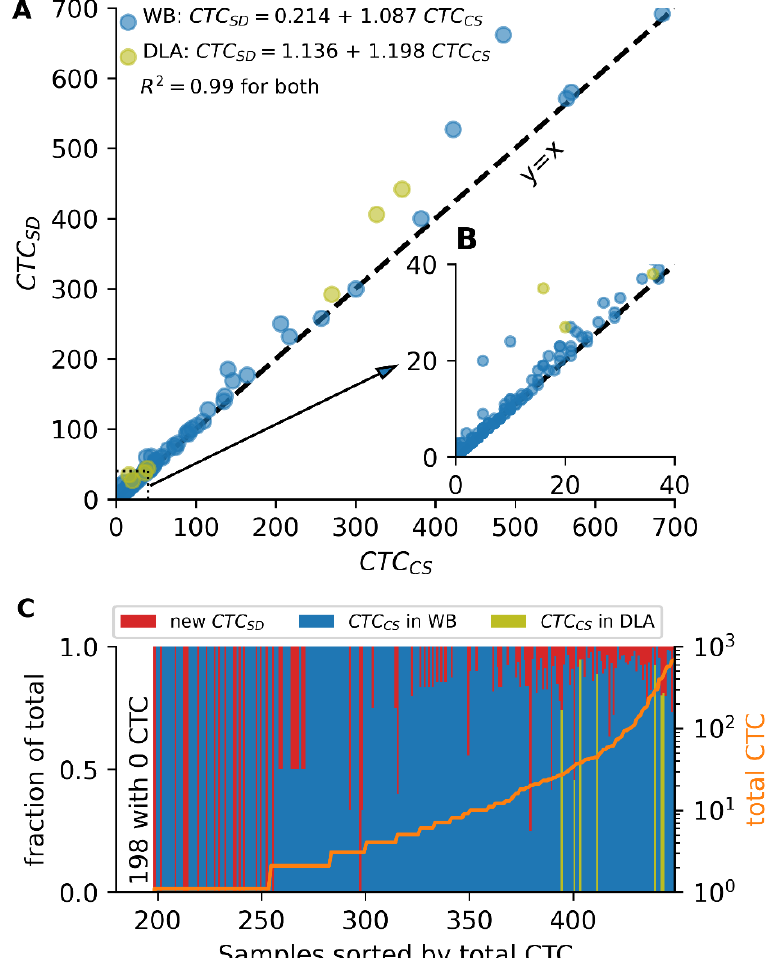
Figure 5. CTC found by CellSearch and StarDist segmentation in archive images of whole blood and DLA. ( A ) Comparison of the original number of CTC found by CellSearch and the combined number of CTC found after evaluation of additional StarDist segmentation for all samples. ( B ) Zoom in of A showing the samples with <40 CTC only. ( C ) Fraction of total CTC found by original review and StarDist review for each sample. Samples are sorted on the total number of CTC as depicted by the orange line. The first 198 samples have no detected CTC and therefore have no fractions.